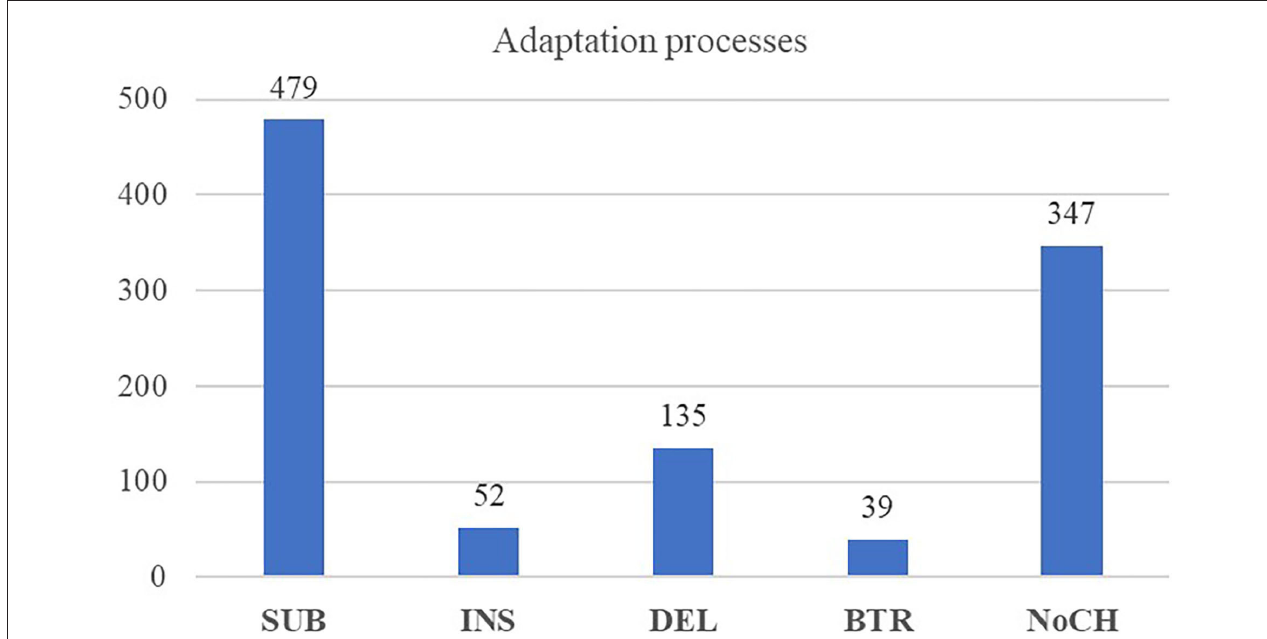
FIGURE 2 | Number of occurrences of different adaptation processes (total N = 1,079, including NoCH). SUB, substitution; INS, insertion; DEL, deletion; BTR, boundary transgression; NoCH, no